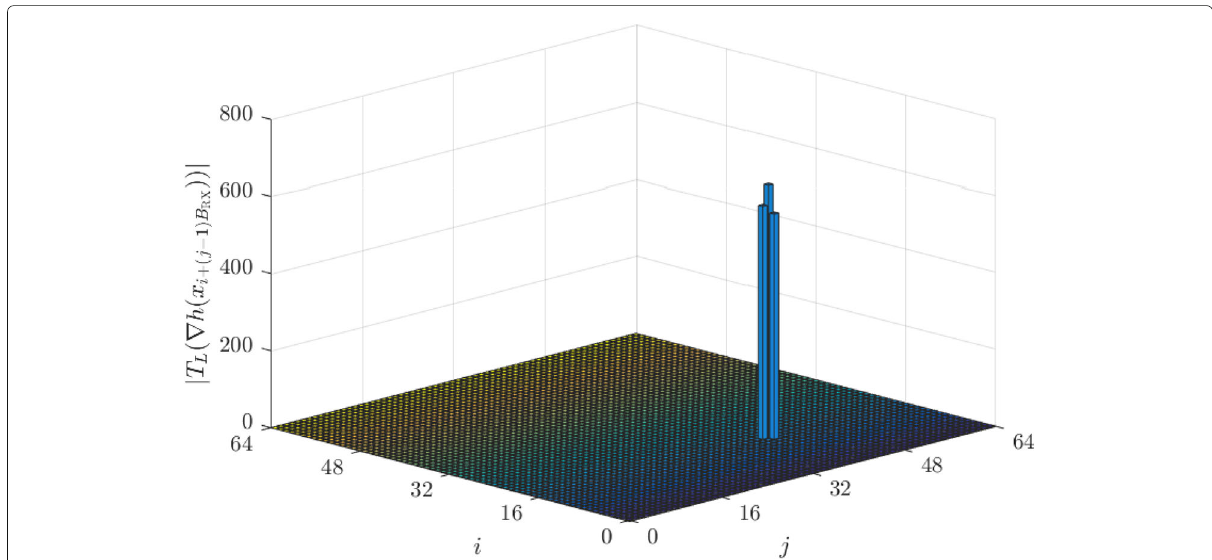
Fig. 3 The magnitude of unvec ( T L ( ∇ h ( x ))) ∈ C B RX × B TX at x = 0 B , namely, after hard thresholding. This shows how hard thresholding on ∇ h ( x ) results in an incorrect estimate of supp ( x ∗ ) when A is highly coherent. In this example, M = N = 16, B RX = B TX = 64, T = 20, L = 4, SNR = 20 dB, and supp ( x ∗ ) is widely